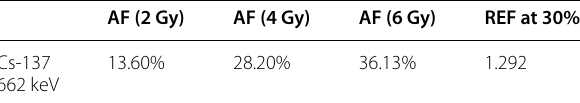
Table 1 AFs and REF of GNPs on Cs‑137 therapy calculated from cell SF versus radiation